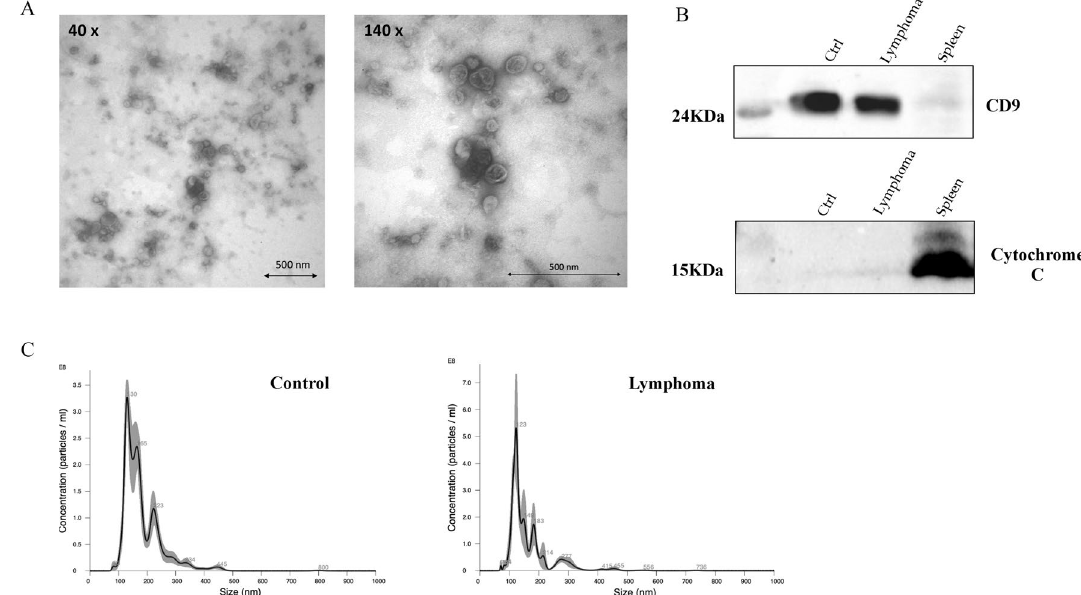
( C ) Representative NTA analysis of the particle size (nm) of SEVs isolated from control and lymphoma group showed particles around 30–150 nm in diameter, performed through